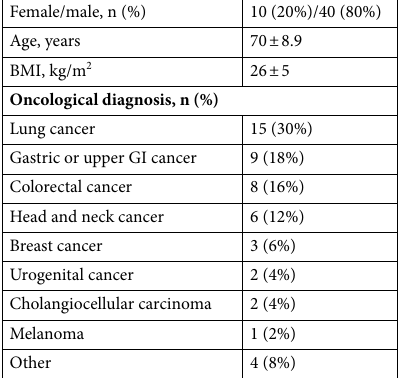
Table 1. Demographics of study patients ( n = 50). Values given are mean ± standard deviation or absolute numbers and percentages in brackets. This table describes demographics of the patients included in this study such as their oncological diagnosis, age, body mass index and gender. BMI body mass index, GI gastrointestinal.